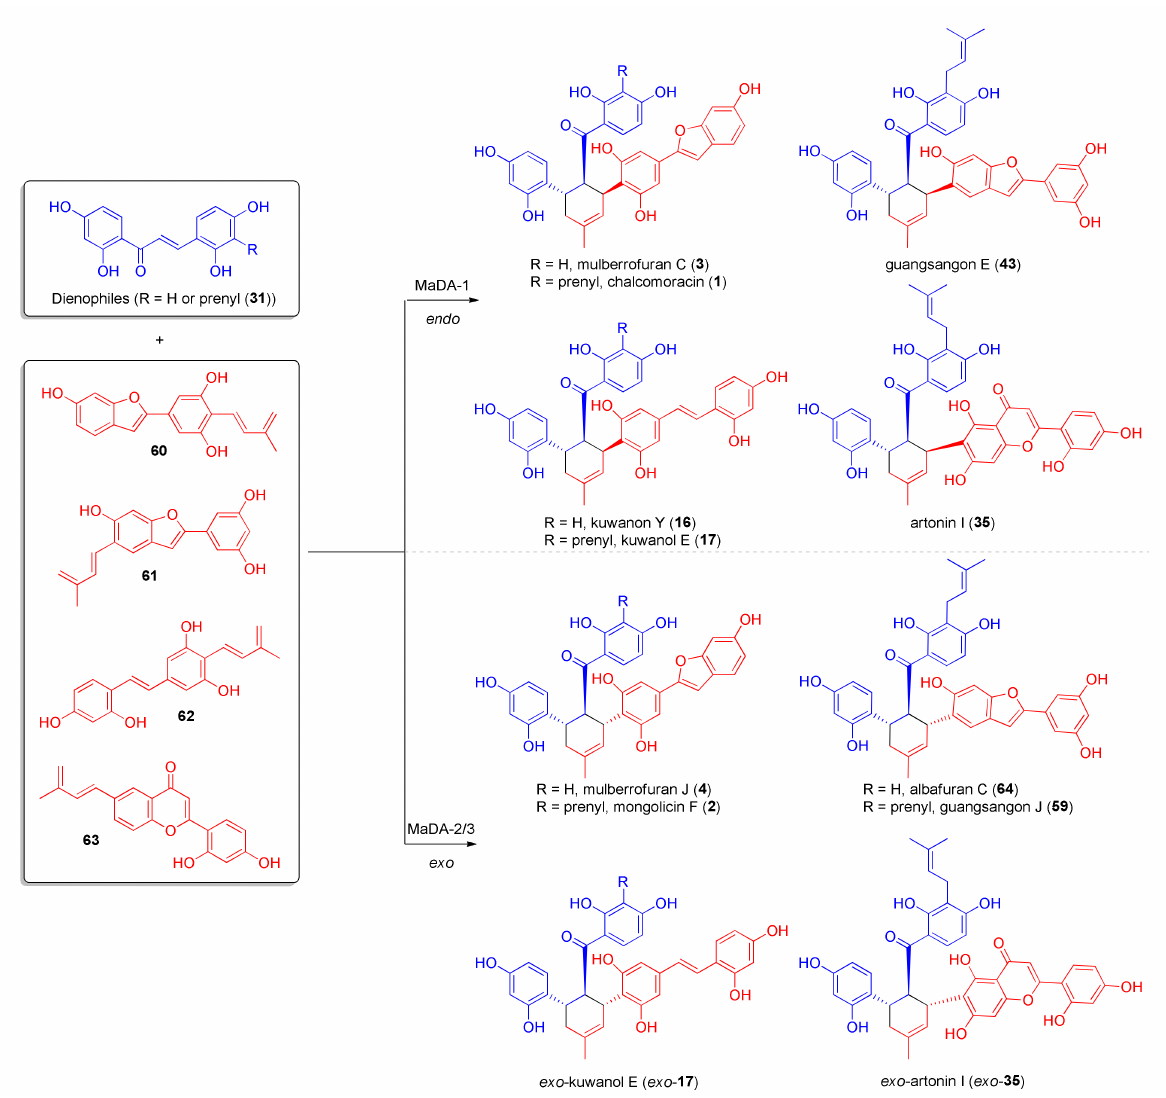
Figure 18. Chemoenzymatic total synthesis of natural DAAs using MaDA-1 ( endo -selective) or MaDA-2/MaDA-3 ( exo